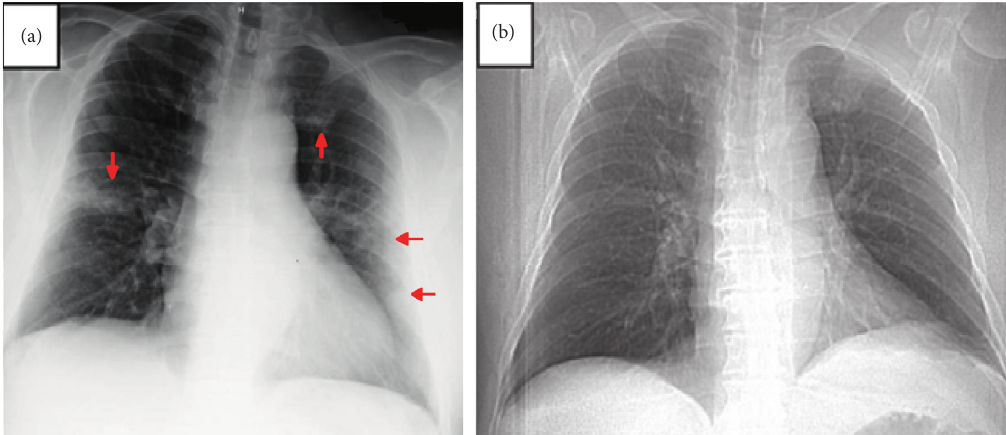
Figure 2: Chest radiographs of the patient. (a) Chest radiograph on presentation to the emergency department; the arrows delineate areas of patchy opacities that tend to favor the lung periphery. (b) Scout film from a previous high-resolution chest CTapproximately 1.5 years prior to his COVID-19 presentation for comparison.